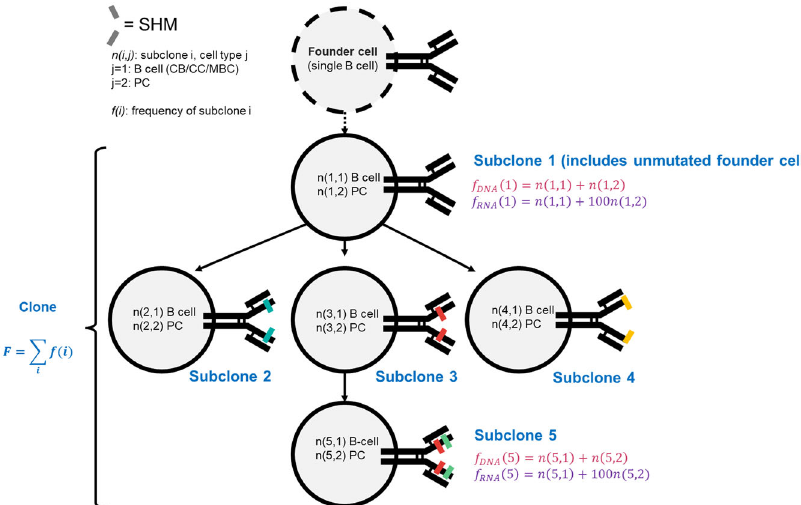
Fig. 3 De fi nition of (sub)clones and their frequencies in the context of a B-cell lineage tree. The founder cell is shown for completeness and is represented by a single cell that enters the GC. Each circle represents a subclone is a group B cells that have the same (mutated) BcR sequence. Different mutations in different positions of the BcR are represented with colored slashes. The fi ve subclones have a common unmutated ancestor and together de fi ne a clone. Each subclone is a mixture of CBs, CCs, MBCs, and PCs although a subclone may also consist of a single cell type. The frequency f DNA (i) of a subclone is determined by counting the number of cells for each subclone. This frequency can be experimentally obtained with DNA-based repertoire sequencing. Alternatively, frequencies f RNA (i) can be determined from RNA-based sequencing but this may arti fi cially increase the subclone frequency if the RNA content of PCs is much higher (a factor of 100 in the fi gure) compared to CBs/CC/MBCs. The frequency F of a clone is the sum of the RNA-based or DNA-based frequencies of the